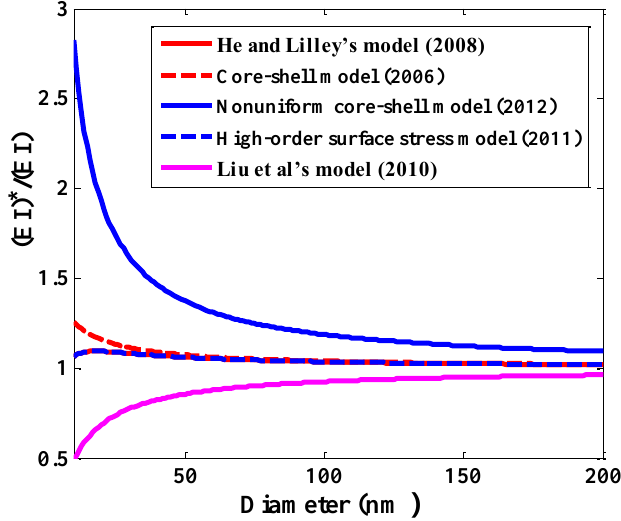
Figure 14. Comparisons of normalized effective bending stiffness in circular NWs calculated by different surface elasticity models with surface layer thickness 1